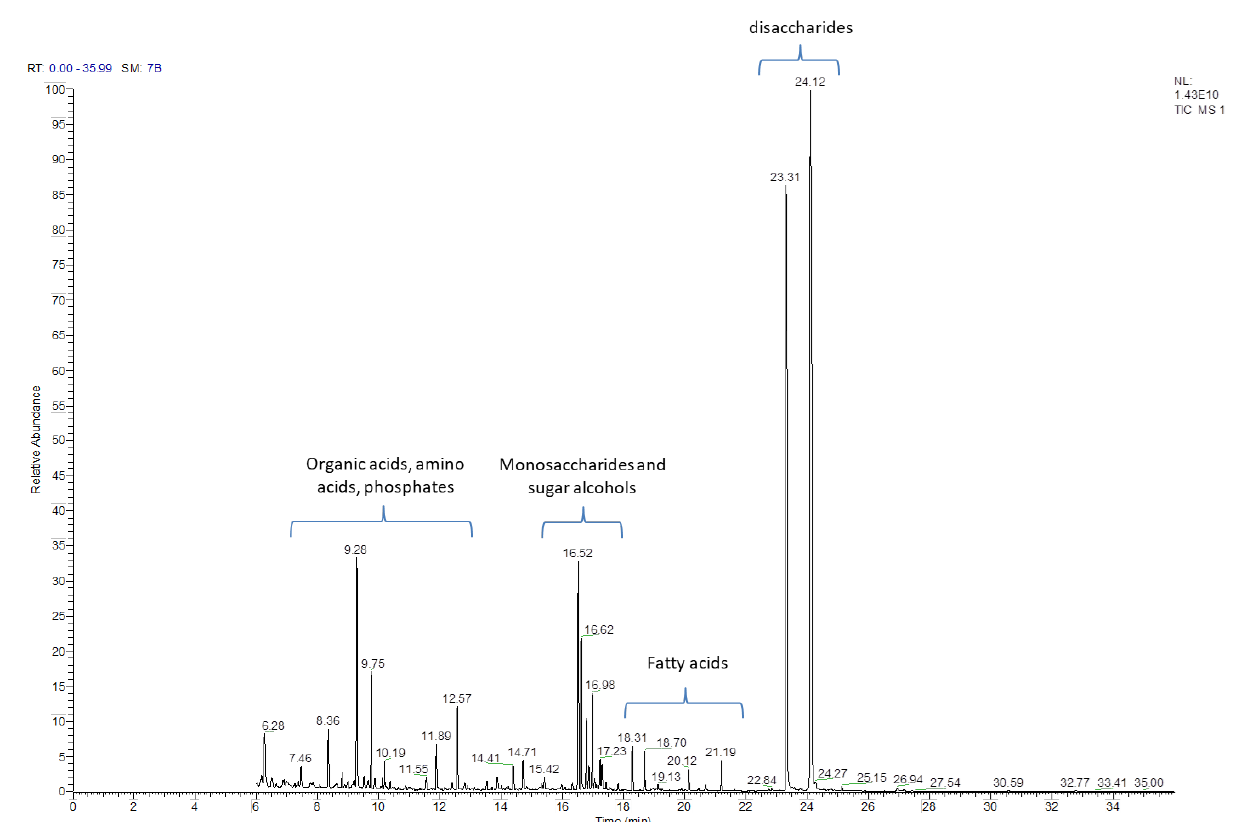
Figure 2. GC-MS chromatogram of post-culture medium after two week long culture of the Cyathea delgadii cell suspension.